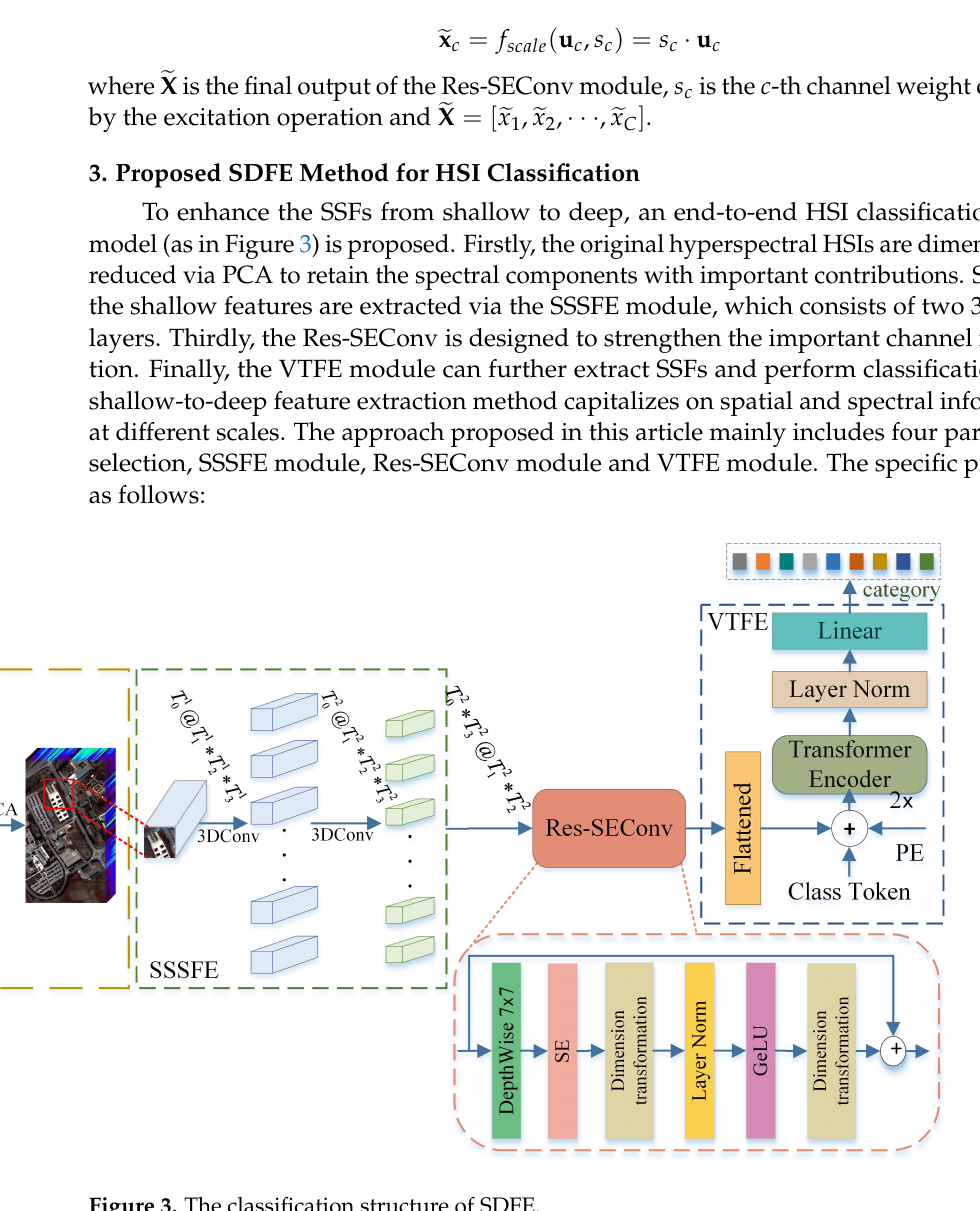
Figure 3. The classification structure of